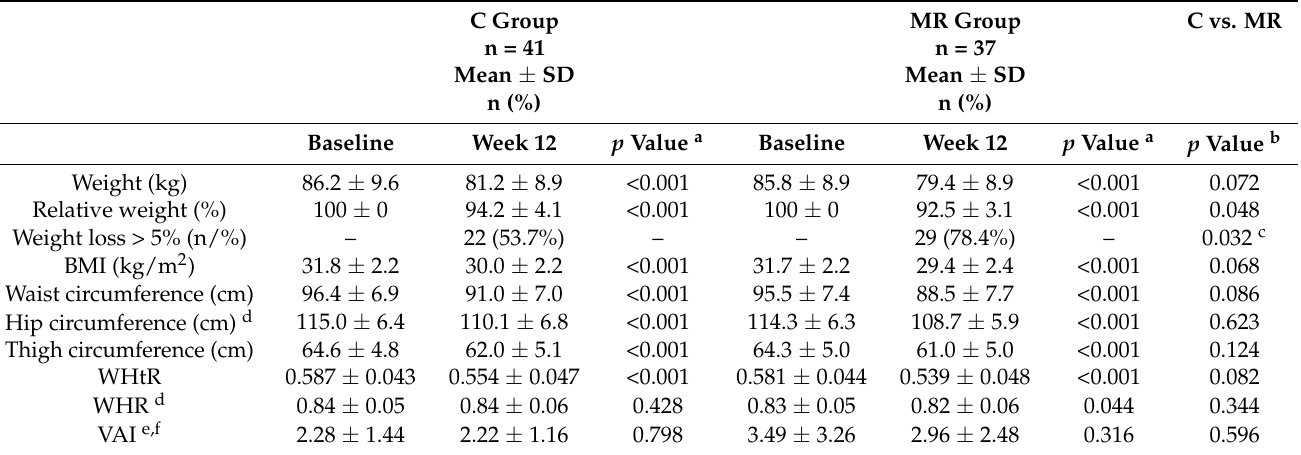
Table 2. Anthropometric and clinical characteristics in overweight women at baseline and after dietary